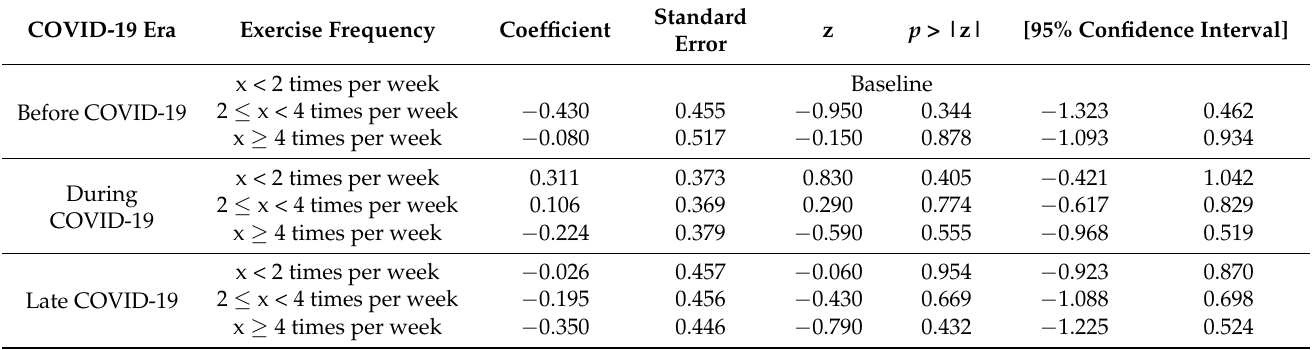
Table 2. The effect of the COVID-19 era and exercise frequency on mental distress among men.